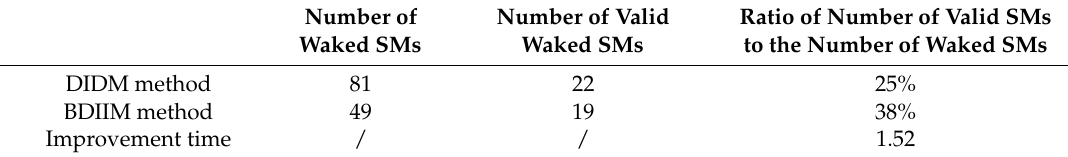
Table 5. Data of the SM performance of nodes in WC.